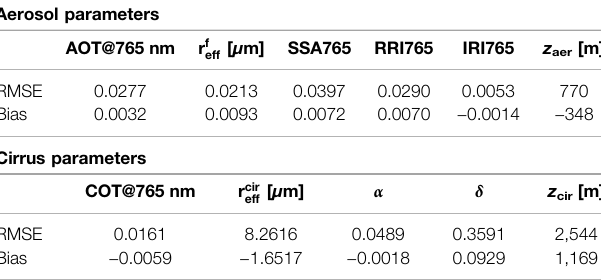
TABLE 6 | Retrievals of aerosol parameters for MAP-CO2I baseline case, and retrievalsofcirrusparametersattruecirrus-contaminatedpixelswithtrueCOT > 0, by fi tting cirrus in MAP-CO2I